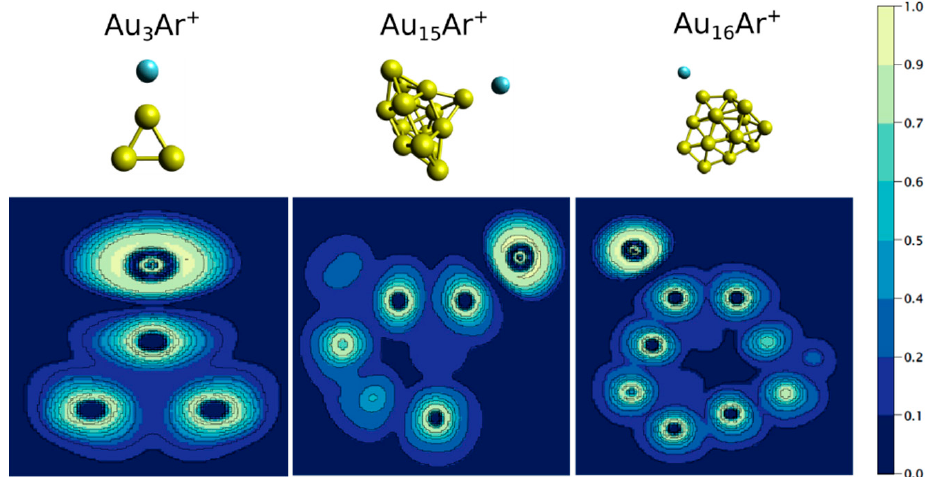
Figure 7. Electron localization function (ELF) of Au 3 Ar + , Au 15 Ar + and Au 16 Ar + . At the top of each panel, the geometry of the cluster is presented.